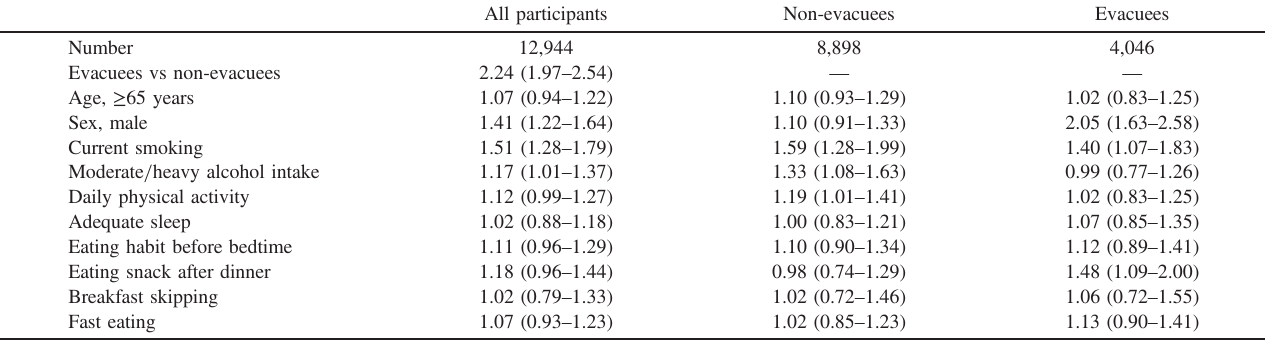
Table 2. Multivariable-adjusted odds ratios and 95% CIs of abdominal obesity after the disaster for variables among participants without abdominal obesity before the disaster All